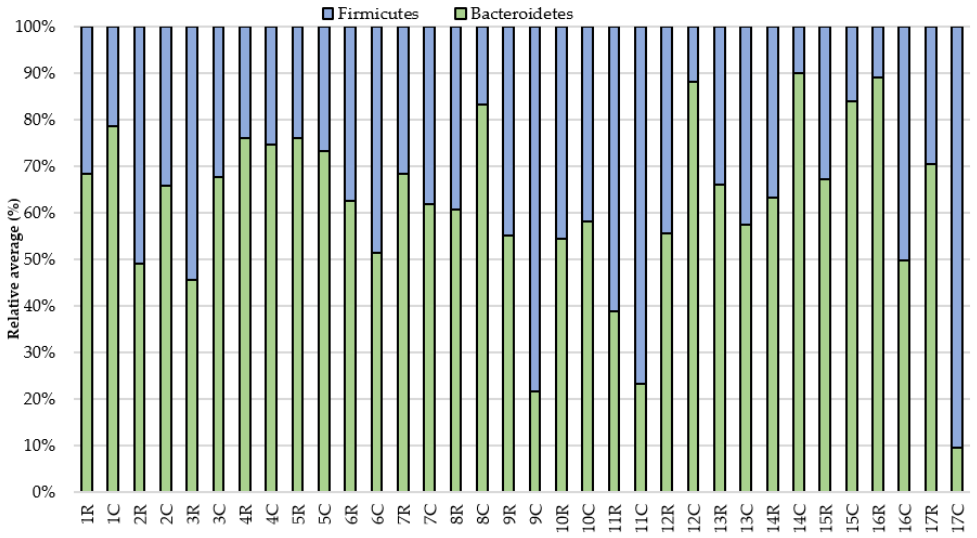
Figure 2. The relative average of the studied groups in the feces of animals before (C) and after race (R).